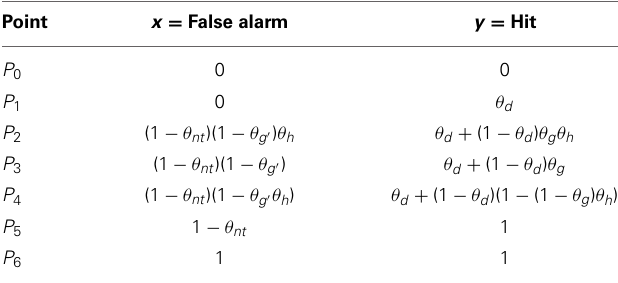
Table 3 | The PD model equations for the key points shown in Figure